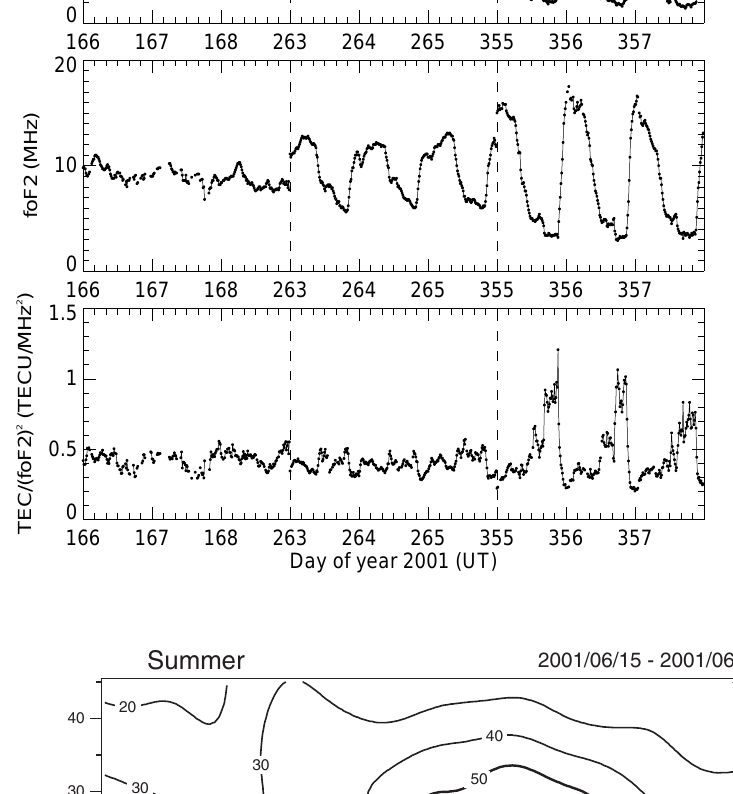
Fig. 6. A 15-min time series of TEC at 35 ◦ N, 139 ◦ E for 9 days over a six- month time span. Vertical lines divide inconsecutive days. Also shown are 15- min time series of fo F2, the ration of TEC to the square of fo F2.